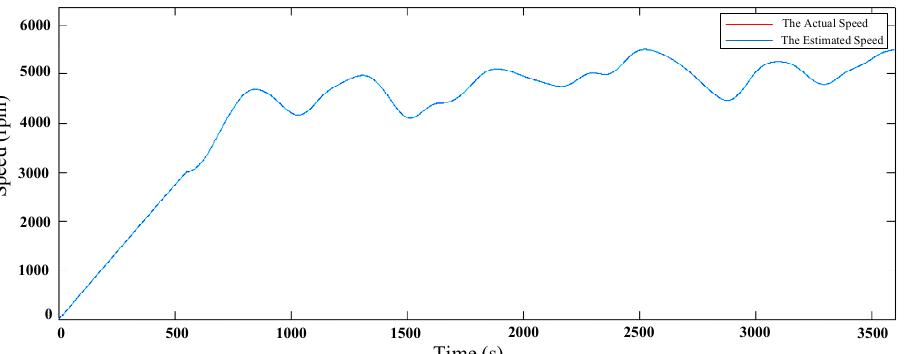
Figure 9. The waveform diagram of the flywheel rotor speed.